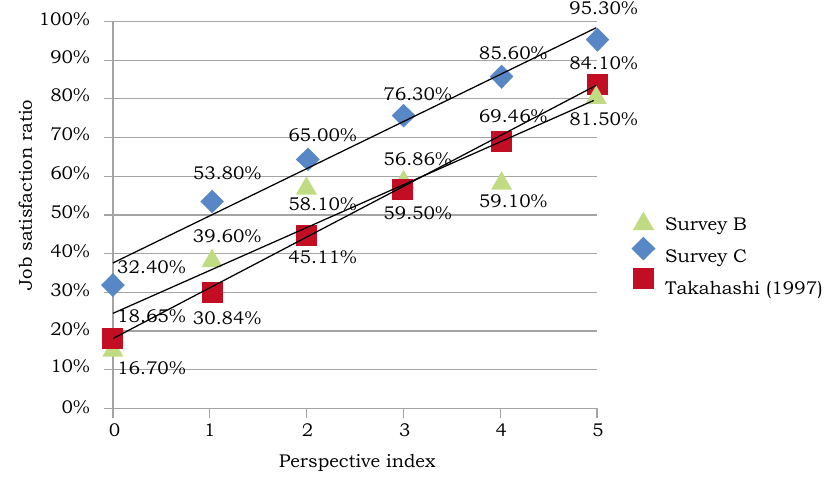
Figure 1. Perspective index and job satisfaction